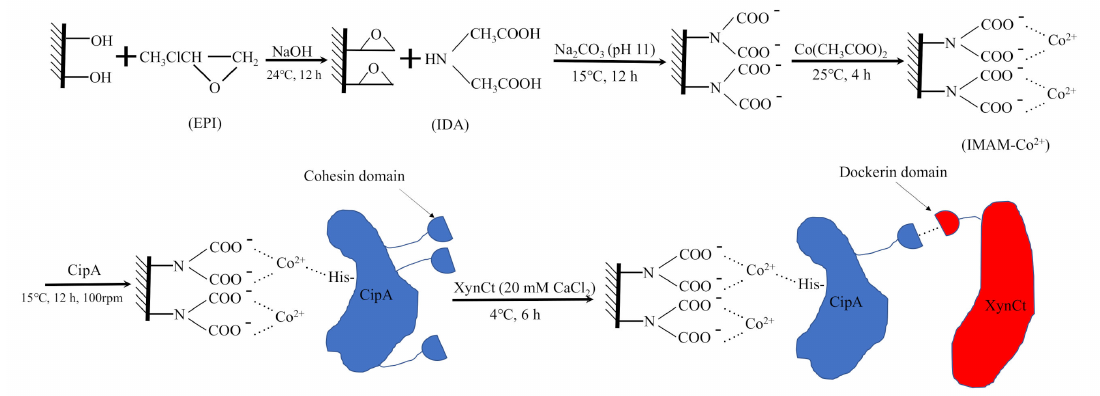
Figure 1. Schematic representation of the preparation of immobilized metal ion a ffi nity membrane (IMAM)-Co 2 + -CipA-XynC-DocT (XynCt). EPI, epichlorohydrin; IDA, iminodiacetic